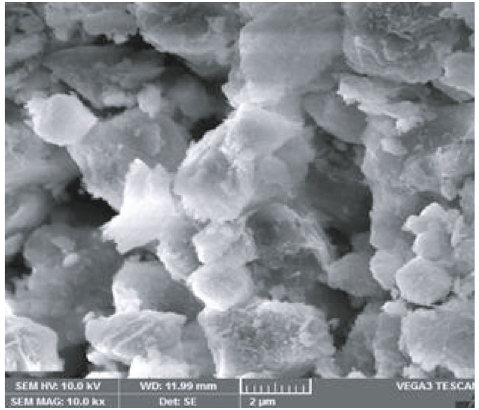
Figure 3: SEM image of